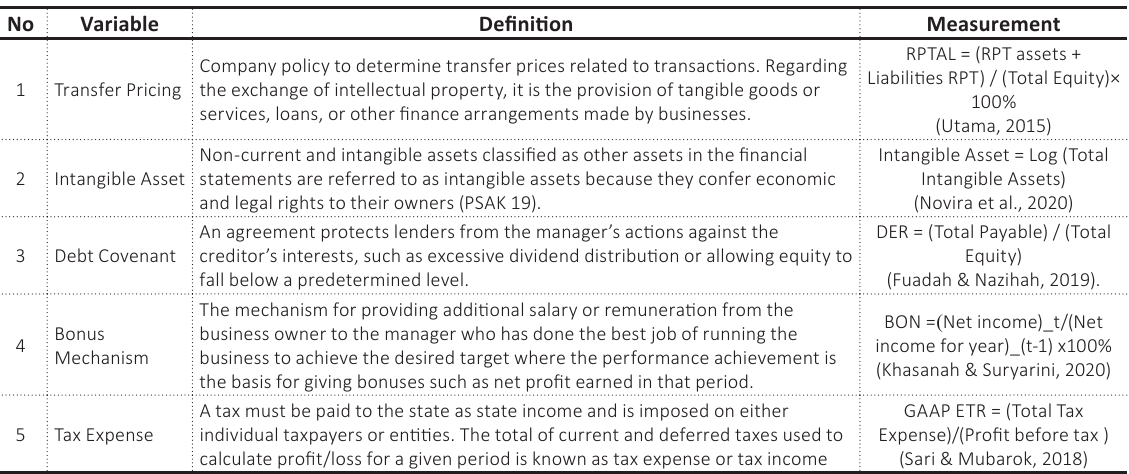
Table 2. Operational definition of variable